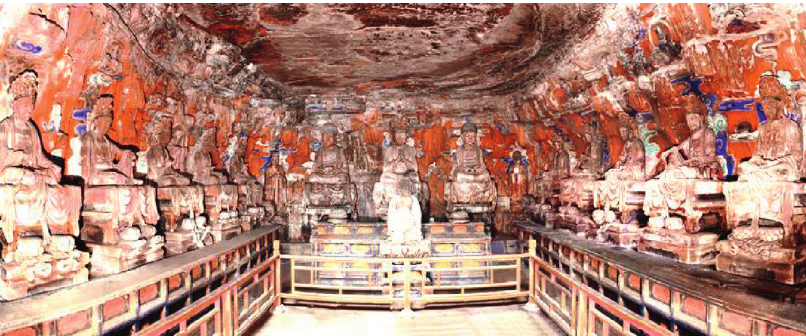
Figure 1: Internal structural features of Yuanjue Cave.